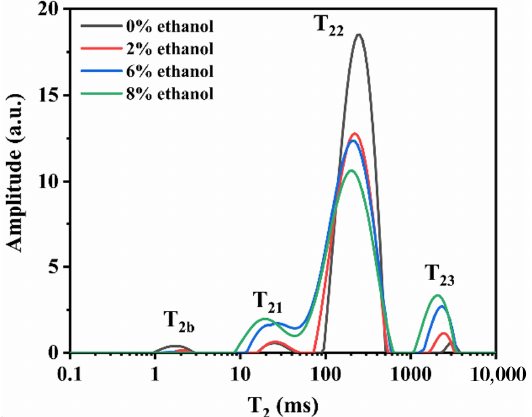
Figure 4. Distributions of T 2 relaxation times of konjac emulgel-based fat analogue (KGFA) with different ethanol content without freeze-thaw treatment.